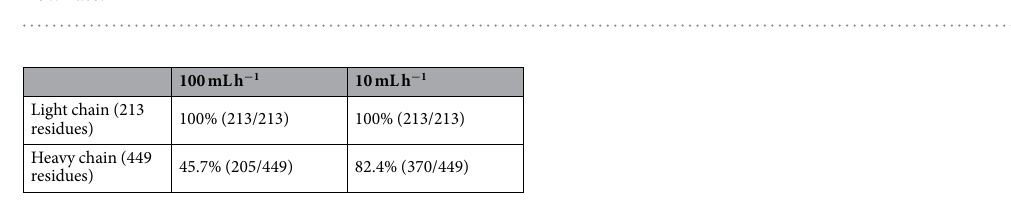
Figure 8. The UV chromatograms for repeatability of online digestion with the Pep-SpM under 10 mL h − 1 as flow